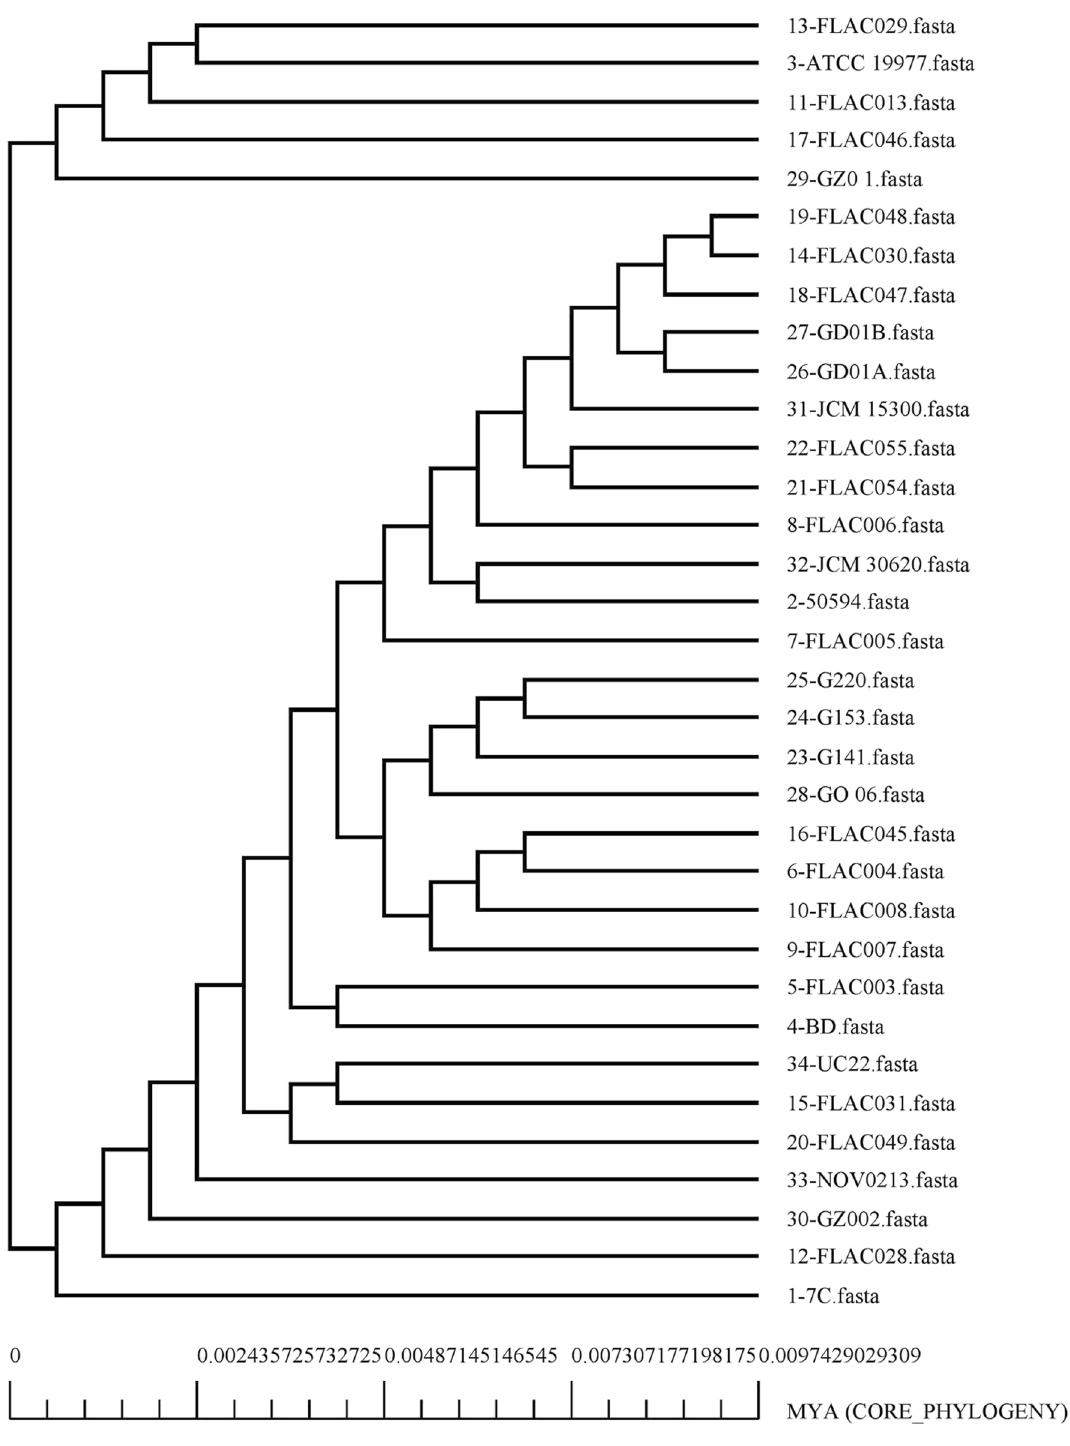
Figure 3. Core genome tree of 34 complete genomes of Mycobacteroides abscessus . This core phylogeny has been obtained on the basis of concatenated alignment of proteins associated with the core